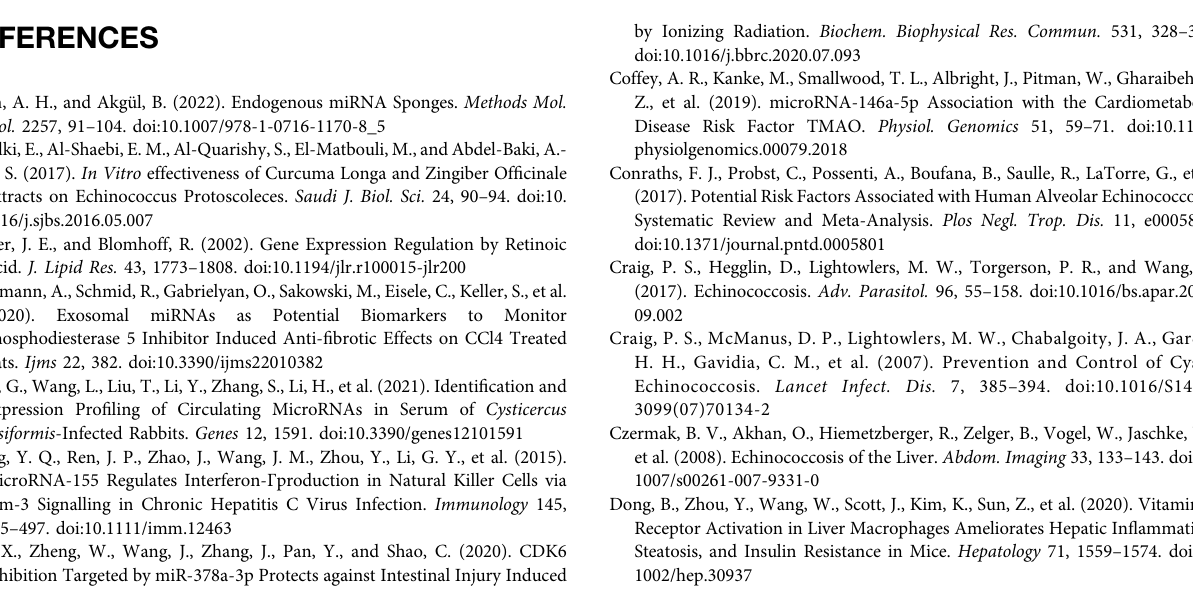
Supplementary Figure 1 | The expression of cell markers in HCs, HSCs and KCs. SupplementaryFigure2| ComparisonsofDElncRNAs,DEmRNAsandDEmiRNAs differentially expressed in HSCs at 2 m p.i. and 3 m p.i.. (A) The number of DElncRNAs, DEmRNAs and DEmiRNAs at two infection stages. Sky blue represents the total number of DEgemes, red and violet represents upregulated and downregulated genes, respectively. (B) Veen diagrams showing the common Supplementary Figure 3 | ComparisonsofDElncRNAs,DEmRNAsandDEmiRNAs differentiallyexpressed inKCs at 2 m p.i. and 3 m p.i.. (A) The number ofDElncRNAs, DEmRNAs and DEmiRNAs at two infection stages. Sky blue represents the total number of DEgemes, red and purple represents upregulated and downregulated genes,respectively. (B) VeendiagramsshowingthecommonanduniqueDElncRNAs, DEmRNAs and DEmiRNAs at two infection stages. SupplementaryFigure4| Thetoptwentyenrichedbiologicalprocessandpathways ofDElncRNAsandDEmRNAsinHSCsat2mp.i.and3mp.i.. (A)